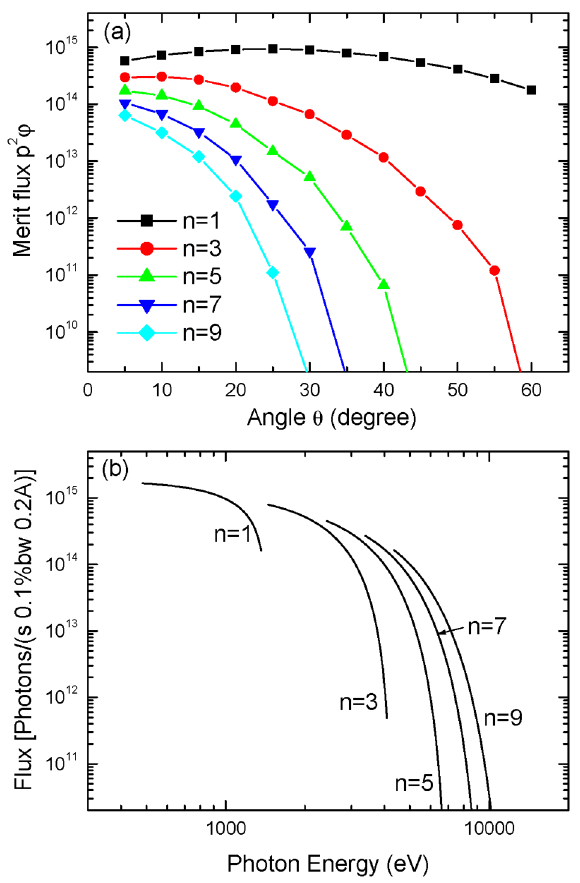
FIG. 10. (Color) (a) Merit flux as a function of the rotation angle (cid:6) of the poles in the staggered undulator and (b) spectrum of each harmonic of the staggered undulator with the poles rotated by 5 (cid:2) . The results were calculated at a magnetic gap of 2 mm in the staggered